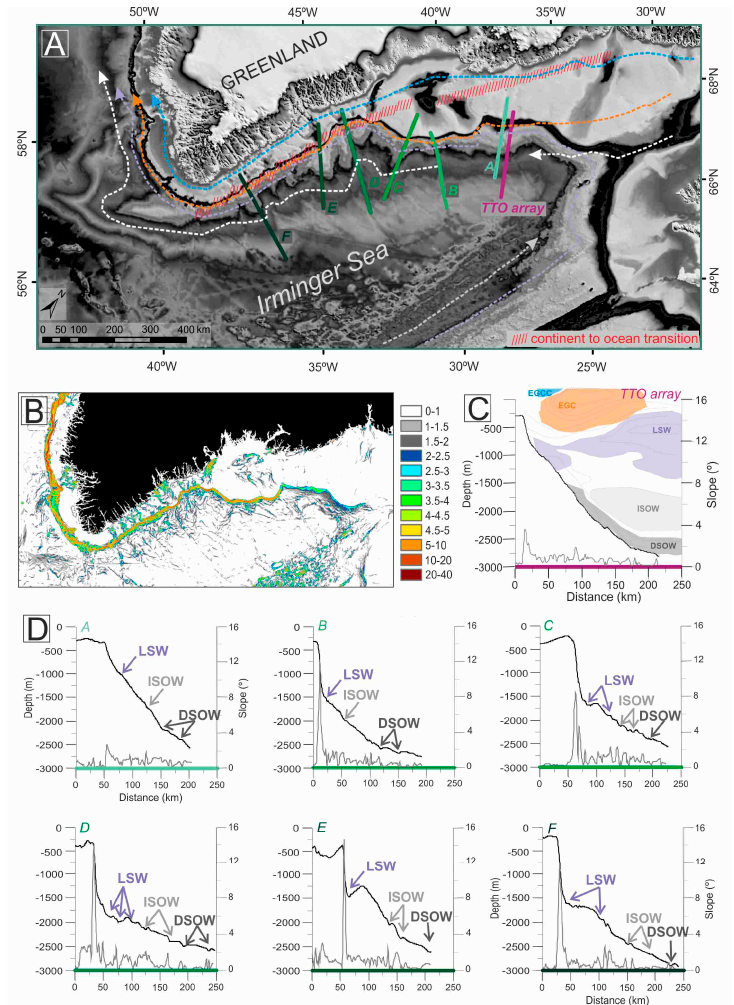
Figure 2. ( A ) Geomorphological map showing the location of the different bathymetric profiles (A to F) and location of the oceanographic Transient Tracers in the Ocean (TTO) array [32]. The dashed lines indicate the different bottom currents. The currents have the same colour as in Figure 1. The hatched line indicates the continent-to-ocean transition as defined by Larsen [20]. ( B ) ArcGIS generated slope angle map showing the different slope gradients in the study area and the location of some of the larger canyons. ( C ) The vertical water mass structure of the TTO salinity section [32] plotted on top of a more accurate bathymetric profile (black line on the graph) obtained from the International Bathymetric Chart of the Arctic Ocean (IBCAO) map [18]. The grey line on the graph at the bottom shows the slope angle generated with ArcGIS. ( D ) Six across slope bathymetric profiles representing the changing steepness in slope. The black lines on the graphs indicate the bathymetric